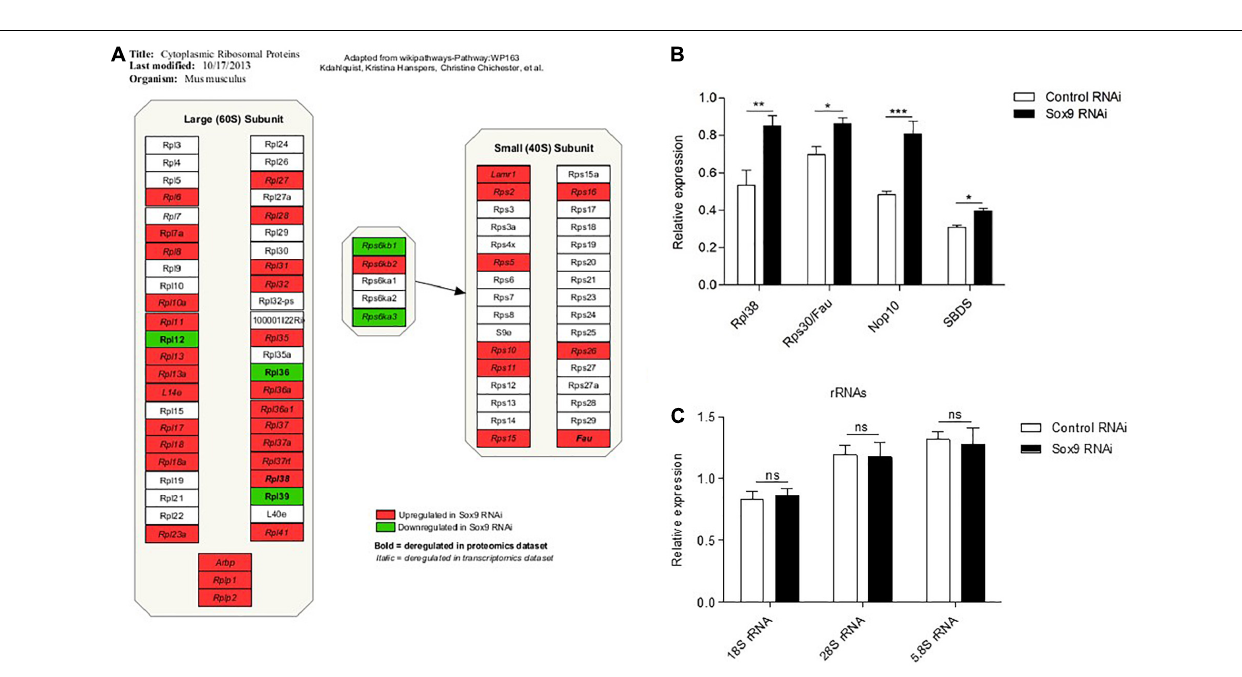
Frontiers in Cell and Developmental Biology |